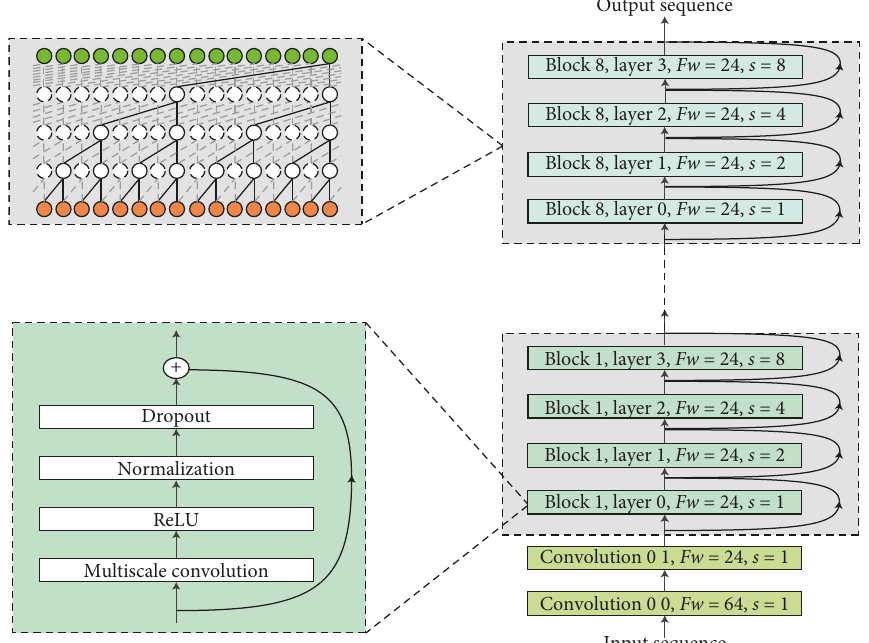
Figure 4: The main structure of the MS-CNN is on the right side. The left-top part shows dilated convolution of a block, and the left-bottom part describes detailed structure in one